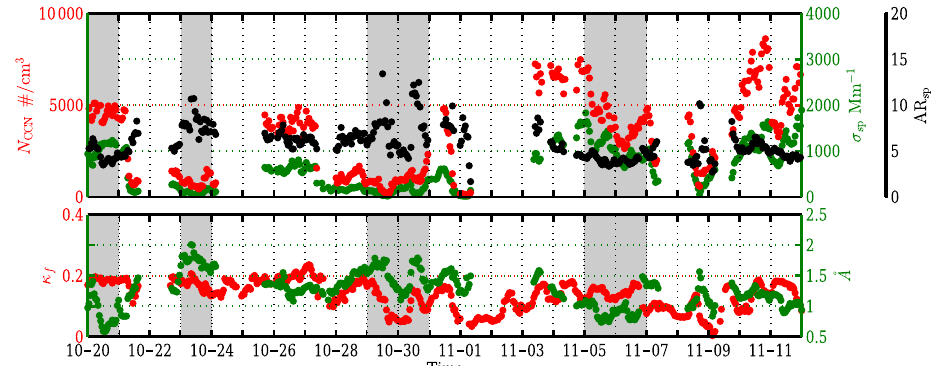
Figure 4. Overview of measurements in Gucheng in 2016. Upper plot: time series of N CCN at a supersaturation of 0.07% (red dots); σ sp at the wavelength of 50nm (green dots); and their ratios (black dots), referred to as AR sp . Lower plot: time series of κ f (red dots) and Å (green dots). The grey bars are periods when the sensitivity of AR sp to κ c is notable.